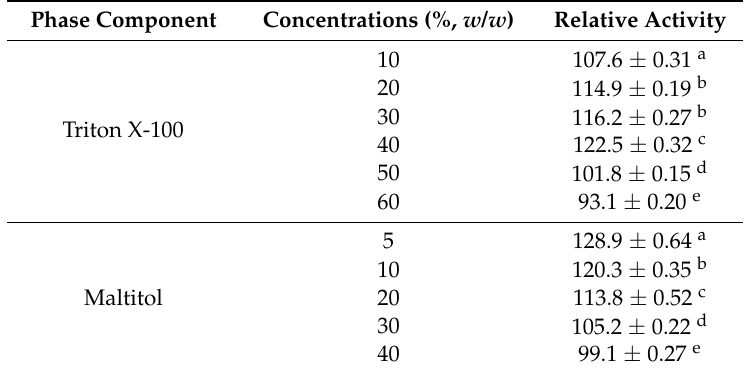
Table 1. Effect of different concentrations of Triton X-100 and maltitol on lipase activity of L. mesenteroides subsp. mesenteroides ATCC 8293. Phase Component Concentrations (%, w / w ) Relative